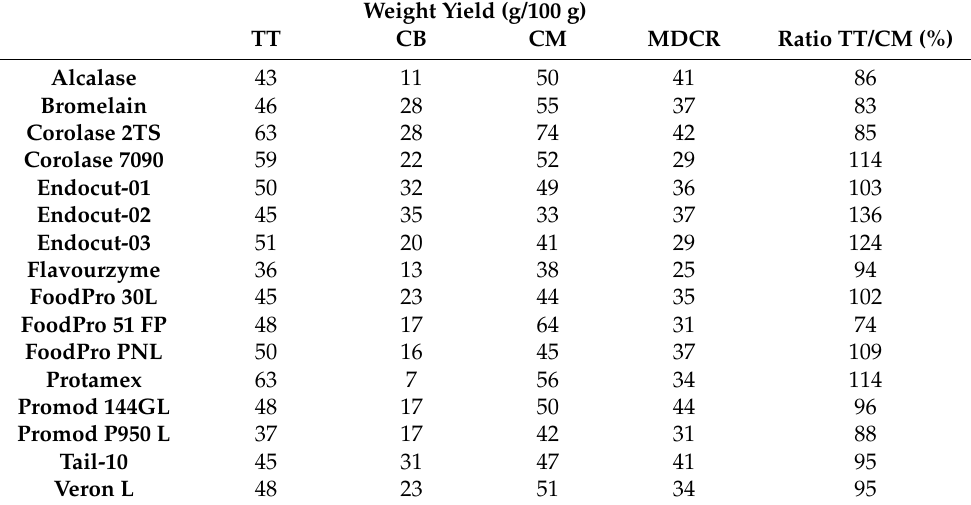
Table 1. Weight yield (g/100 g) after hydrolysis of turkey tendons (TT), chicken bones (CB), chicken meat (CM) and mechanically deboned chicken residues (MDCR) using protease concentrations given in Table S1 for one hour (single hydrolysis). In the right column, the resulting ratios of weight yields from TT over